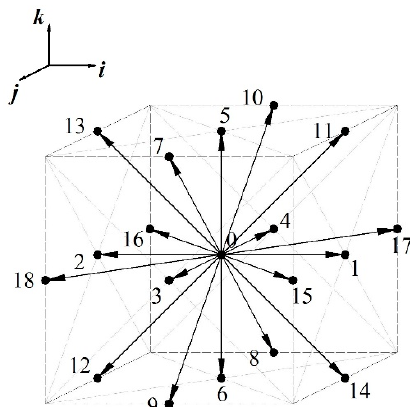
Figure 1. The possible velocity directions in the D3Q19 topology. The speed of discrete velocity | e i | equals 0 when particle keeps its original position after a time step, equals 1 when it moves to the faces of the cubic and 2 to the edges of the cubic.